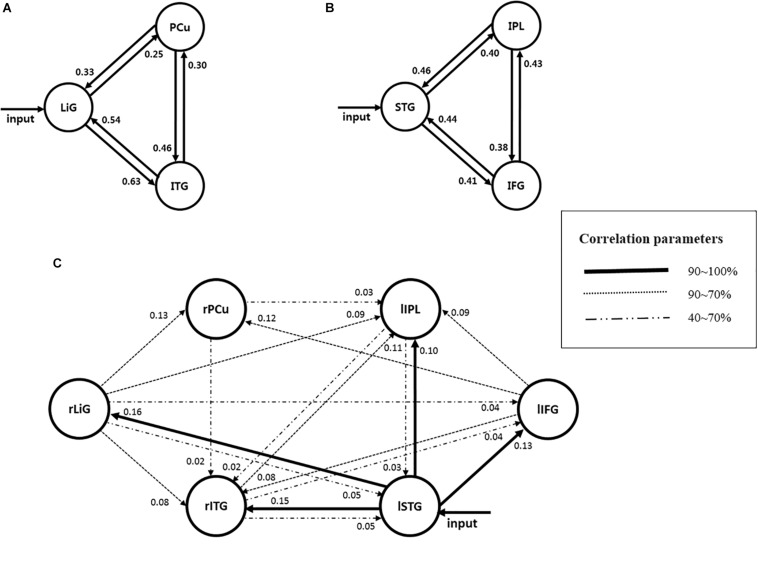
Models estimating the effective connectivity between areas activated during driving in the (A) right, (B) left, and (C) both hemispheres.